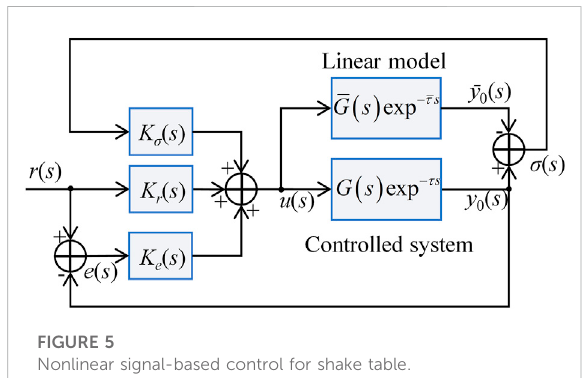
FIGURE 5 Nonlinear signal-based control for shake